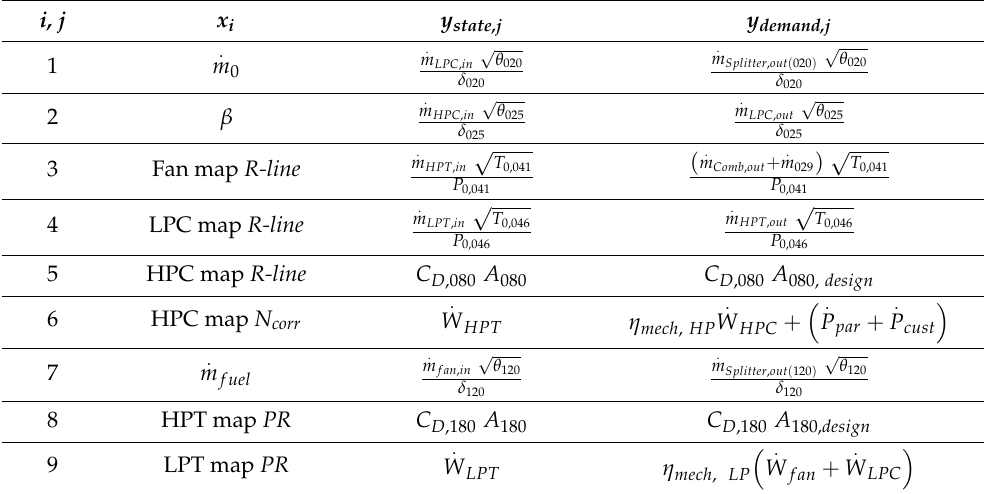
√ . m θ 020 Splitter , out ( 020 ) δ 020 √ . m θ 025 LPC , out δ 025 √ . m ( . m ) T 0,041 029 Comb , out + P 0,041 √ . m T 0,046 HPT , out P 0,046 (cid:16) . (cid:17) . . W HPC + P par + P cust √ . m θ 120 Splitter , out ( 120 ) δ 120 (cid:16) . . W fan + W LPC